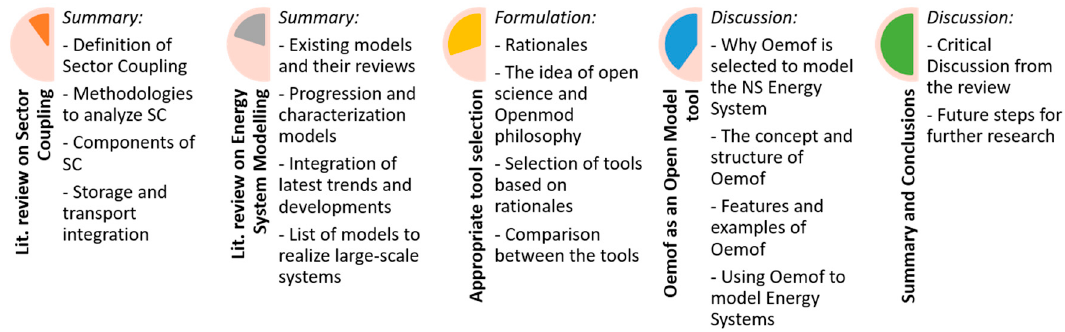
Figure 4. Research Figure 4. Research methodology.